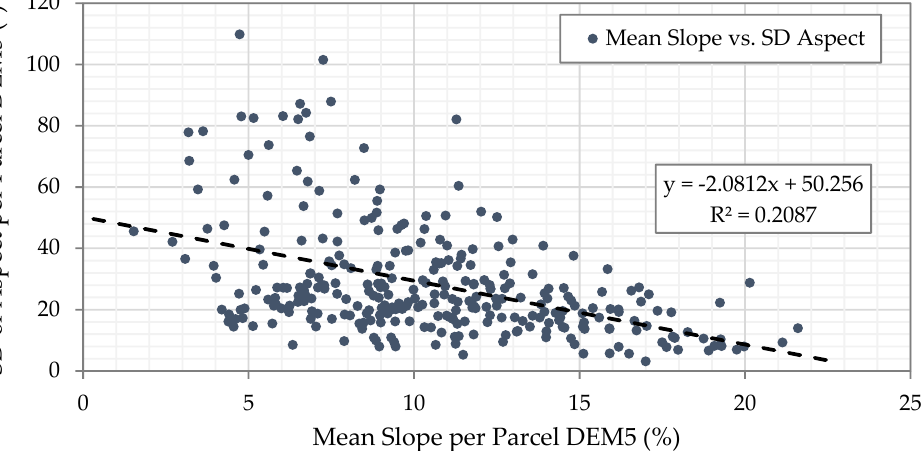
Figure 13. Comparison of mean slope per arable parcel for DEM5 and SD of aspect for DEM5; data source: [30,40].